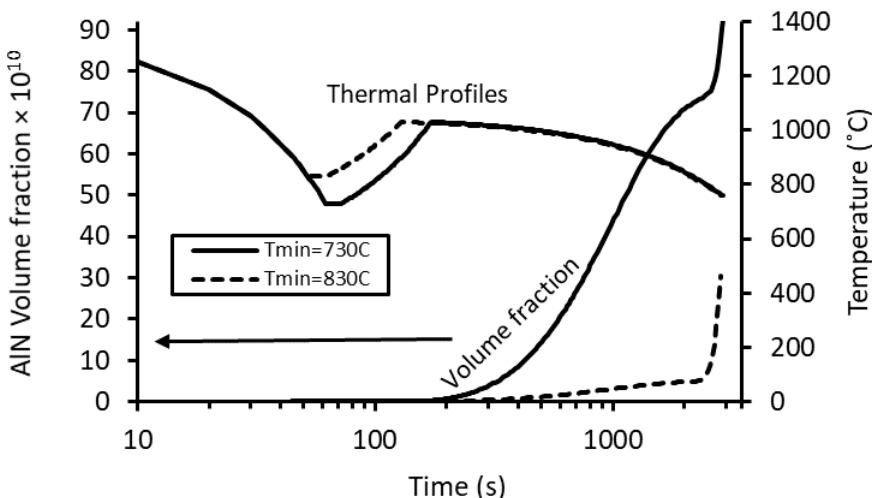
Figure 10. Extremely low AlN volume fraction in austenite (fcc) predicted by TC-PRISMA [9] as a function of T min and rebound temperature of 1030 °C.